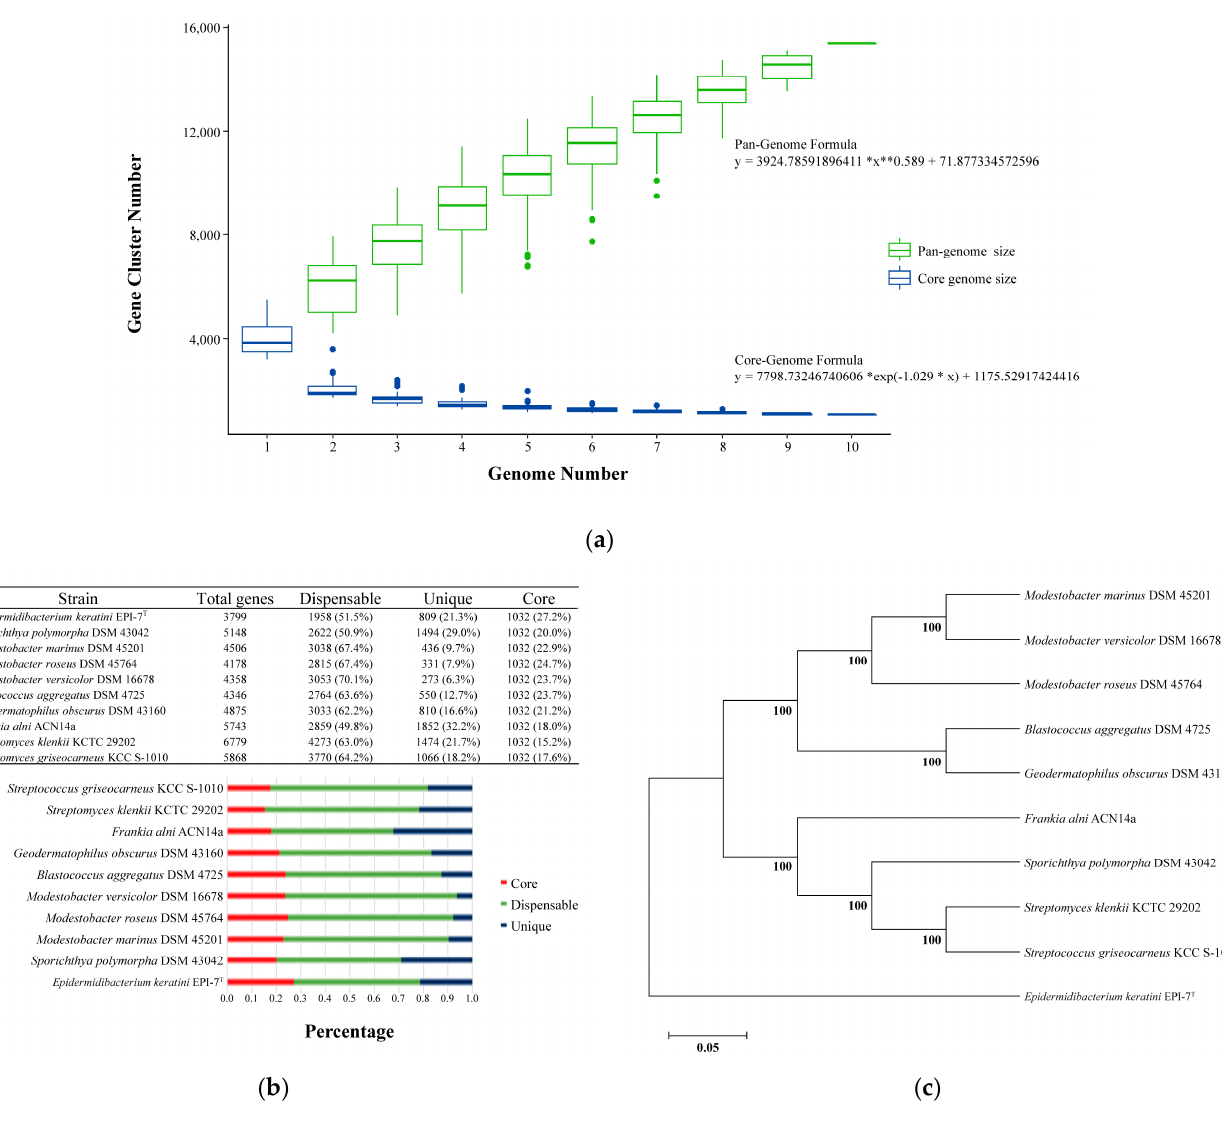
Figure 3. Analysis of pan-genome with species closely related to E. keratini EPI-7 T . Pan-genome anal- ysis with strains closely related to E. keratini EPI-7 T indicated that E. keratini EPI-7 T had low genetic similarity to the comparison strains, which meant that E. keratini EPI-7 T was also genetically